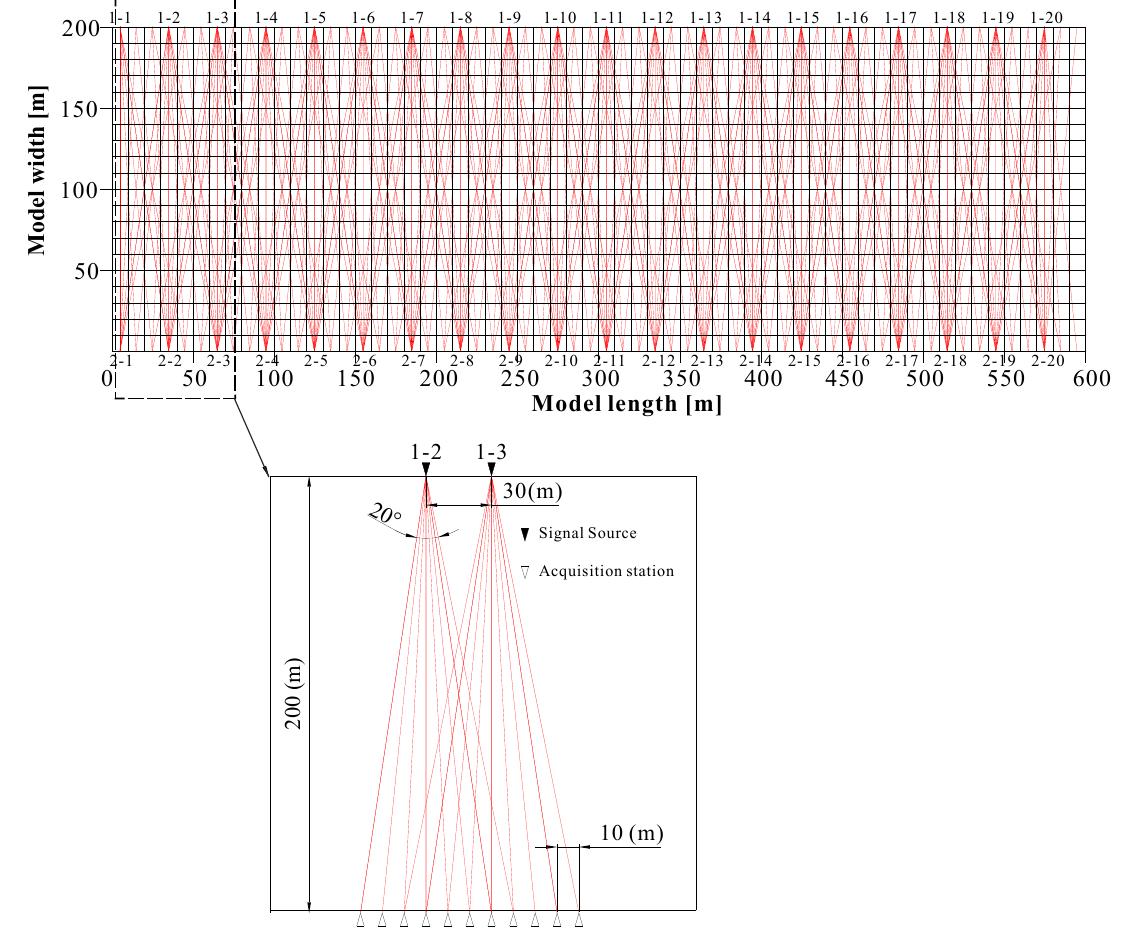
Figure 4. Signal source and acquisition station arrangement in observing